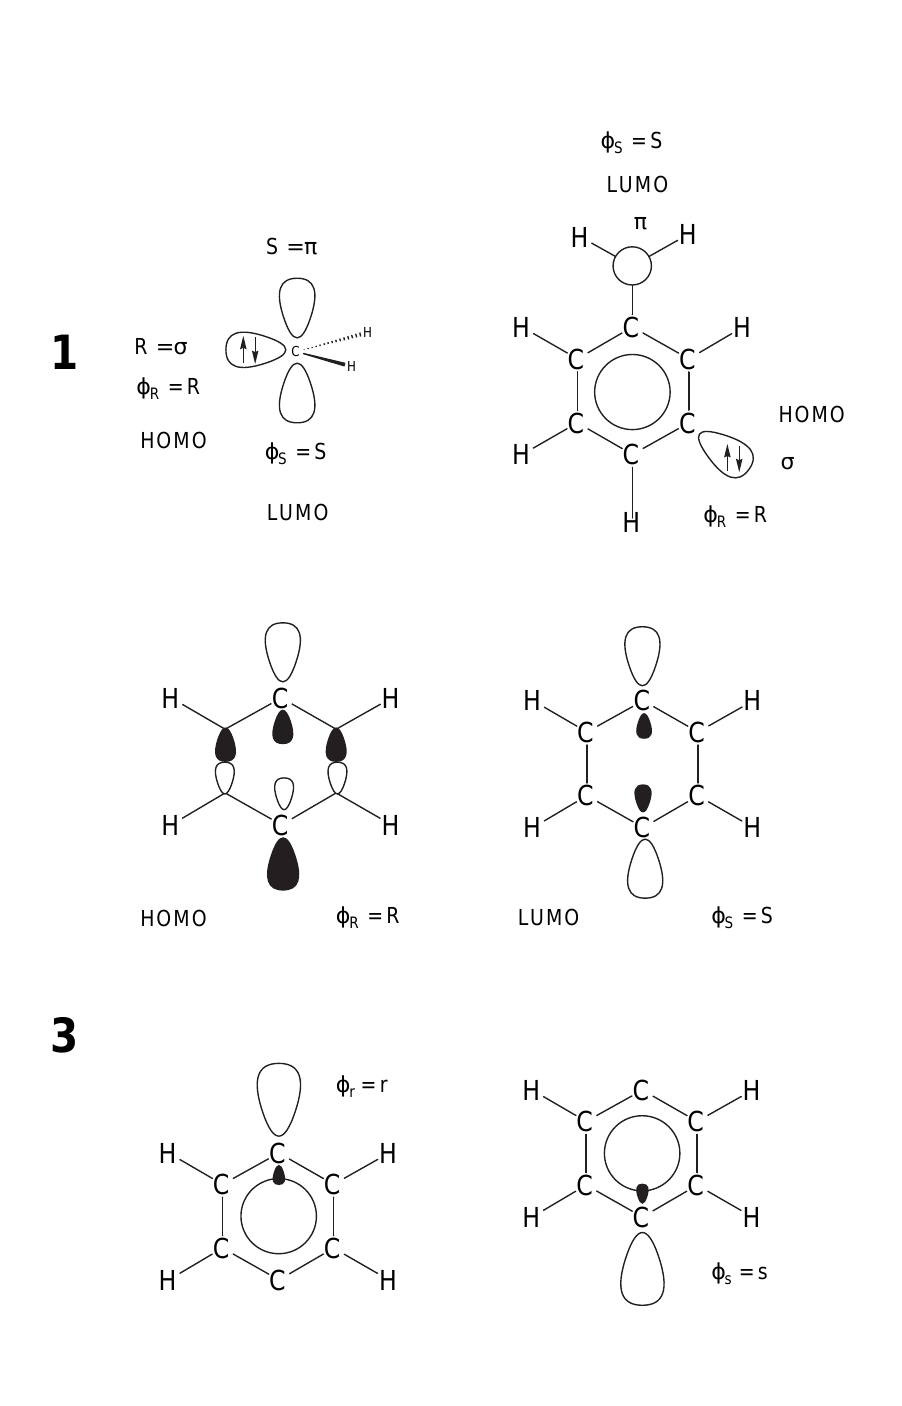
Figure 2a: Schematic representation of HOMO and LUMO for biradicals 1 and 2 . For 3 , HOMO and LUMO are given in canonical (top) and localized (bottom)